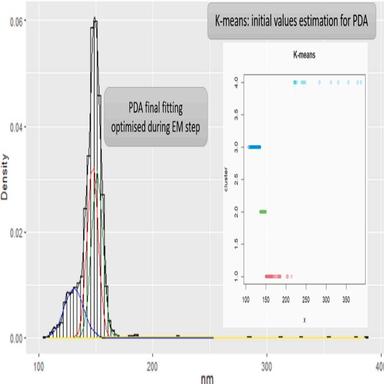
PDA analysis and fitting of histogram plot of the maximum indentation depth after the EM step; initial values for the EM step were provided via kmeans clustering.